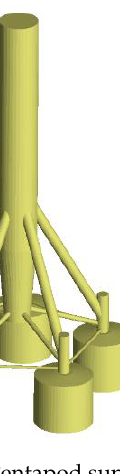
Figure 3. Dimensionless resisting moment of buckets.